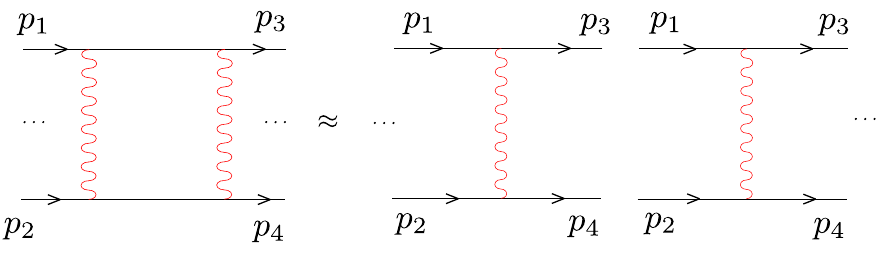
Figure 2 . Tree-level exchange diagrams are the building blocks of ladder